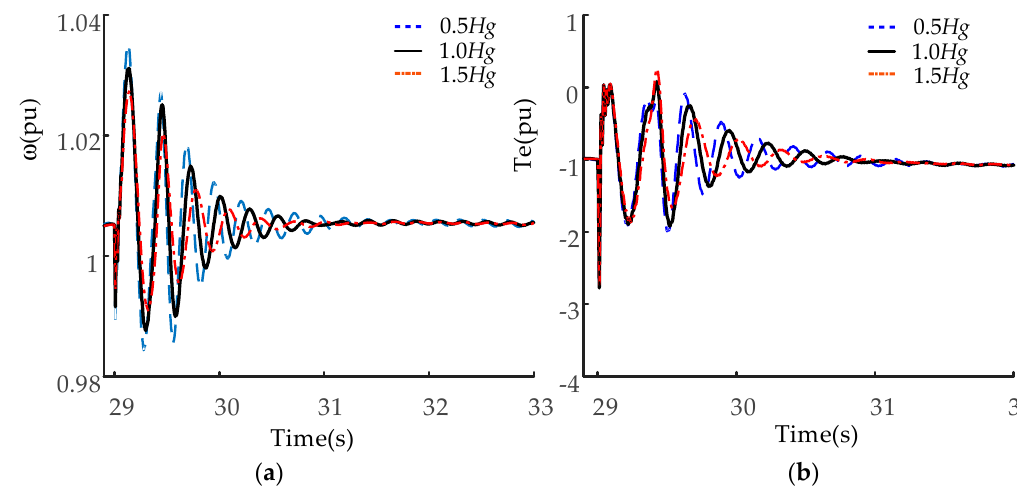
Figure 15. Impact of the three-phase ground fault for different inertia constants H g ( a ) Rotational speed ( b ) Electromagnetic torque.